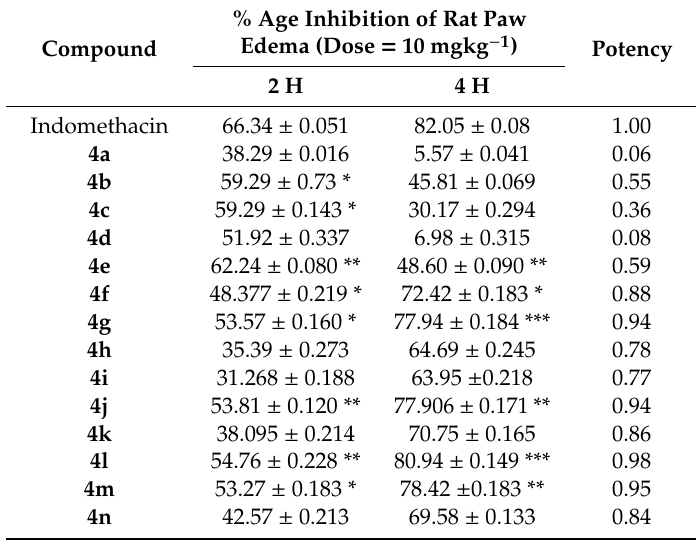
Table 1. Anti-inflammatory activity of 1-(Substituted phenyl amino